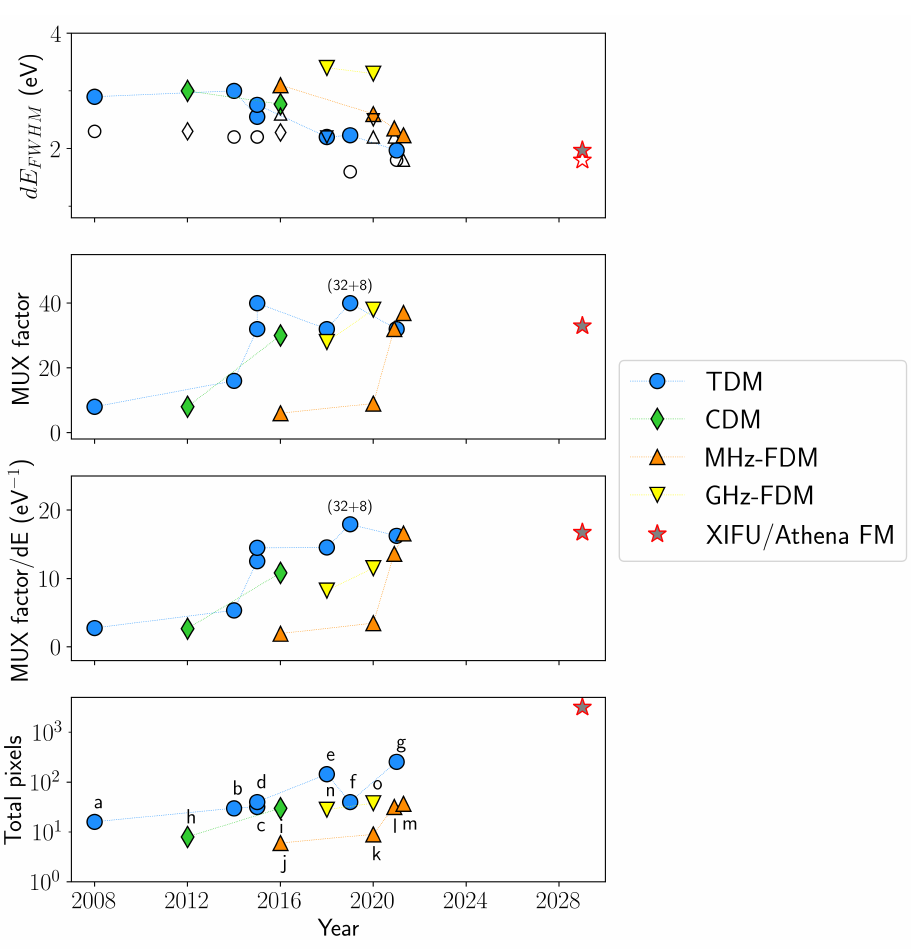
Figure 14. Progress on the multiplexing read-out of TES X-ray microcalorimeters over the last decade. From top to bottom it is shown, for each multiplexing configuration: the multiplexed energy resolution, dE FWHM , for photons at 5.9 keV energy, the multiplexing factor per channel, the multiplexing factor per channel normalized to the energy resolution, and the total number of pixels read-out simultaneously in multi-channel experiments. The empty symbols on the top plot correspond to the energy resolution measured in single pixel mode in the corresponding multiplexing experiments. The star symbol is the expected demonstration of the readout of 3168 pixels with the XIFU/Athena flight model (FM). The data points are taken from the following publications, as annotated in the bottom plot: a = [195], b = [196], c = [9], d = [133], e = [197], f = [128] (32 TESs + 8 repeats of the last row), g = [134], h = [135], i = [10], j = [198], k = [127], l = [148], m = [149], n =[114], o =